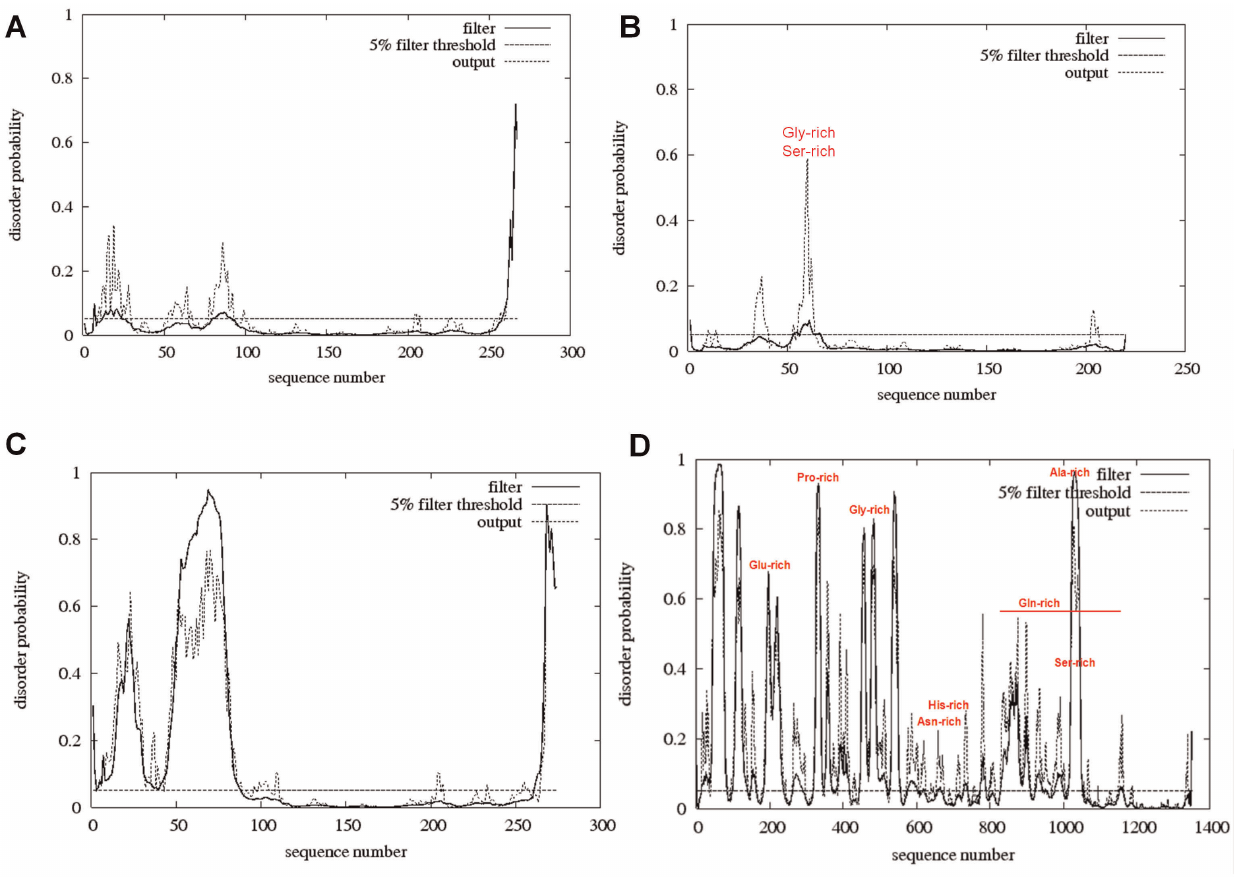
Figure 1. OVOL proteins are characterized by the presence of hypervariable ID regions. A . Mouse OVOL1 has ID residues in the first 100 amino acids. B . Mouse OVOL2 possesses ID residues in the first 50 amino acids with a glycine-rich and serine rich region as marked in red color. C . Mouse OVOL3 has ID segments within the N-terminal 100 residues. D . Drosophila OVO is intrinsically disordered with large patches of residue biasness as indicated by the red color. We used DISOPRED2 software [47] for the prediction of ID regions. The horizontal line indicates the ordered/ disordered threshold for the default false positive rate of 5%. The ’filter’ curve represents the outputs from DISOPRED2 and the ’output’ curve represents the outputs from a linear support vector machine (SVM) classifier (DISOPREDsvm). The outputs from DISOPREDsvm are included to indicate shorter as low confidence predictions of disorder.